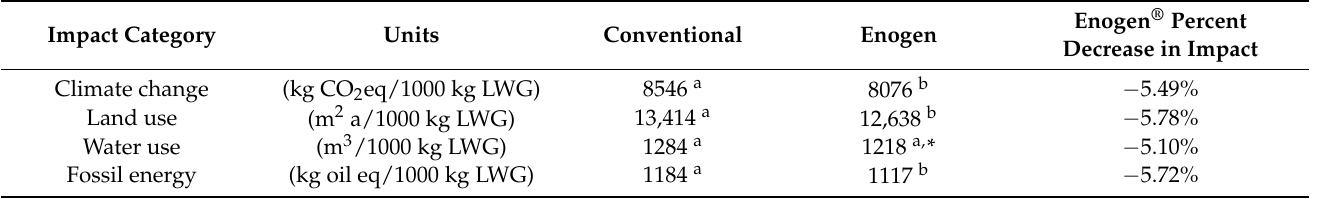
Table 4. Environmental impacts and improvements for gate-to-gate backgrounding plus feed yard (truncated BG; full FY).